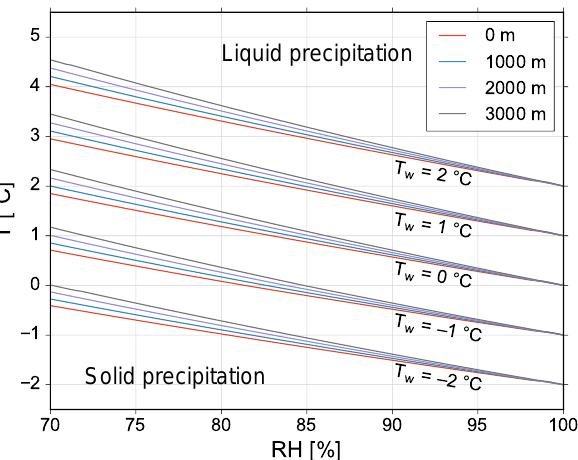
Figure 2. Relation between air temperature, wet-bulb temperature and relative humidity at different altitudes. The latter represent dif- ferent air pressure levels derived using the hydrostatic equation. The colored lines can be interpreted as borderlines to separate liquid and solid precipitation assuming a certain threshold wet-bulb tempera-